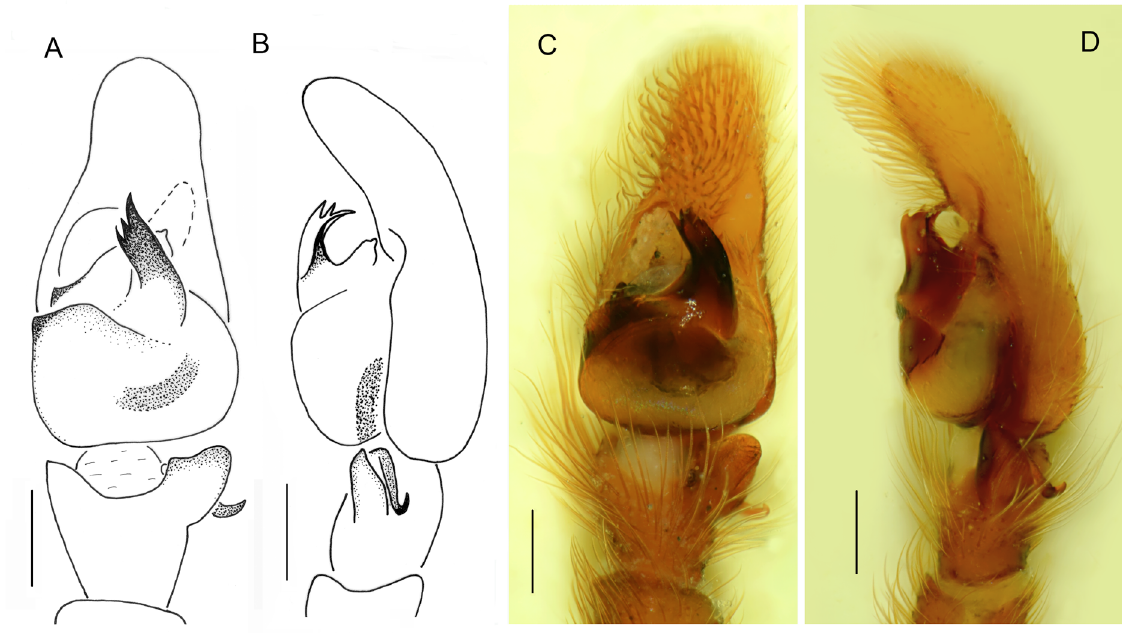
Fig. 3. Pochytoides monticola sp. nov., holotype, ♂. A–D . Palpal organ. A , C . Ventral view. B , D . Retrolateral view. scale bars: 0.3